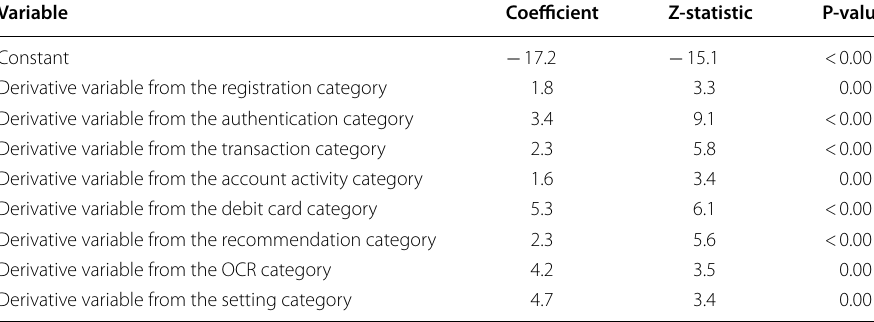
Table 3 Estimation results of the second-stage model Variable